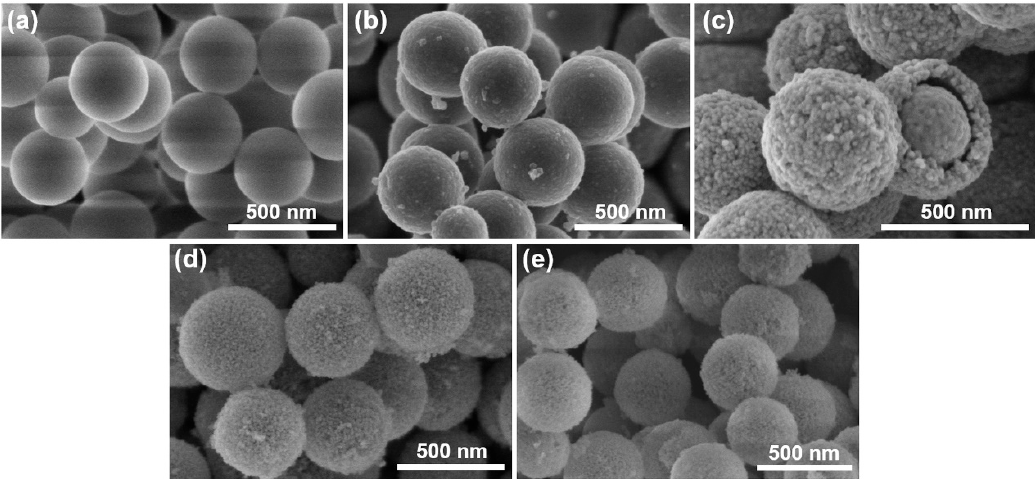
Figure 3. SEM images of ( a ) SiO 2 , ( b ) SiO 2 @TiO 2 /HDA, ( c ) SiO 2 @mTiO 2 , ( d ) SiO 2 @mTiO 2 -bpdc and ( e ) Eu(tta) 3 bpdc- SiO 2 @mTiO 2 .